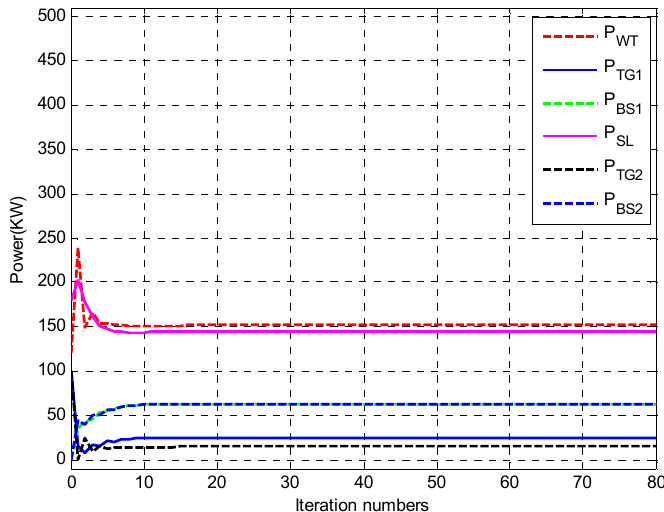
Figure 15. Power output of the proposed method with different parameters.